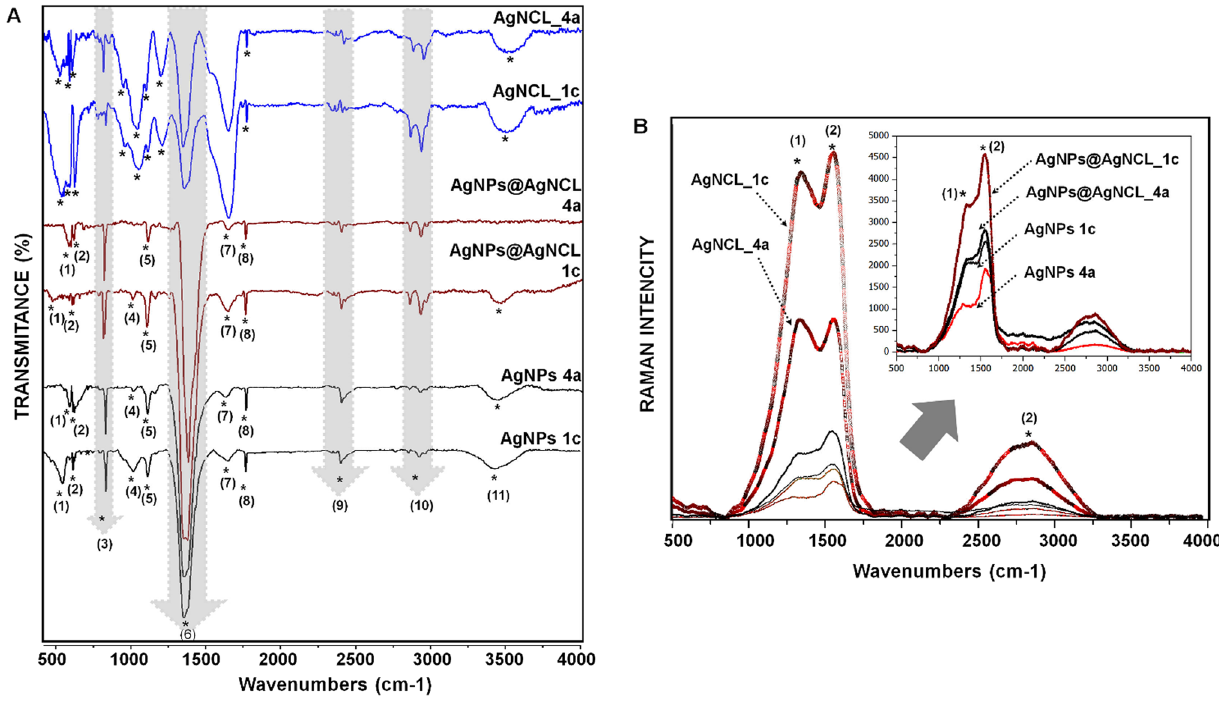
Fig. 5 FTIR ( A ) and RAMAN ( B ) spectra presenting discrepancies between AgNCl and AgNPs, AgNPsH types regarding the organic